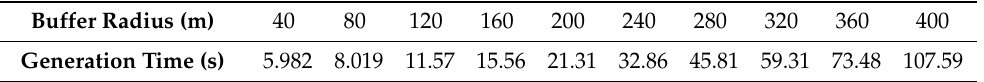
Figure 13. Comparison of the algorithm efficiency of the target area for sphere grid levels of 18 and 19. The X-axis represents the buffer radius, and the Y-axis represents the computation time. Table 3. The radii and generation times of the buffers with a sphere grid level of 18. Buffer Radius (m)